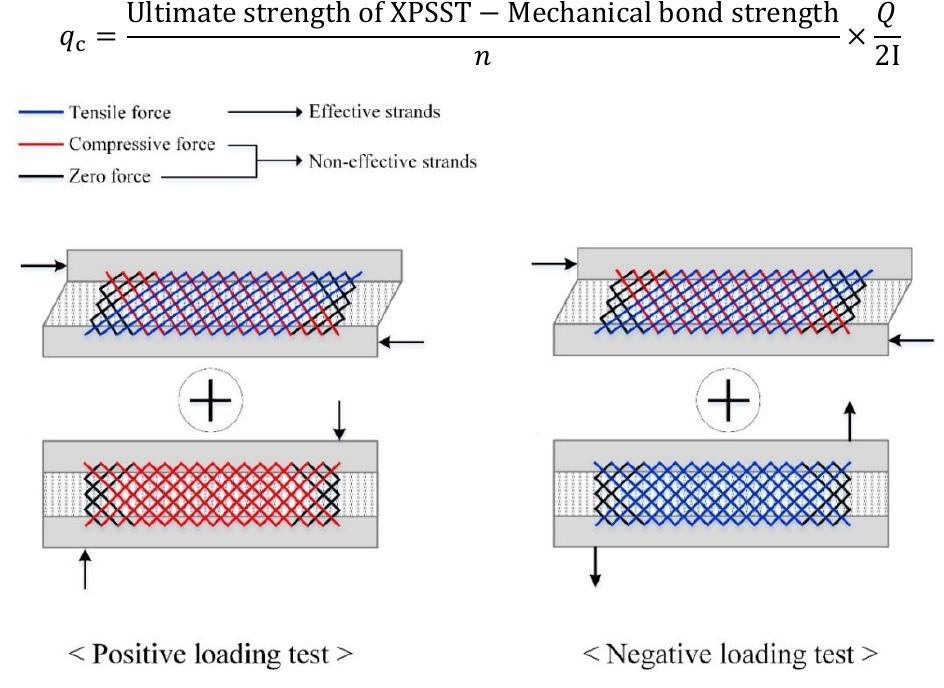
Figure 11. Conceptual effective strands of GFRP grids subjected to positive or negative